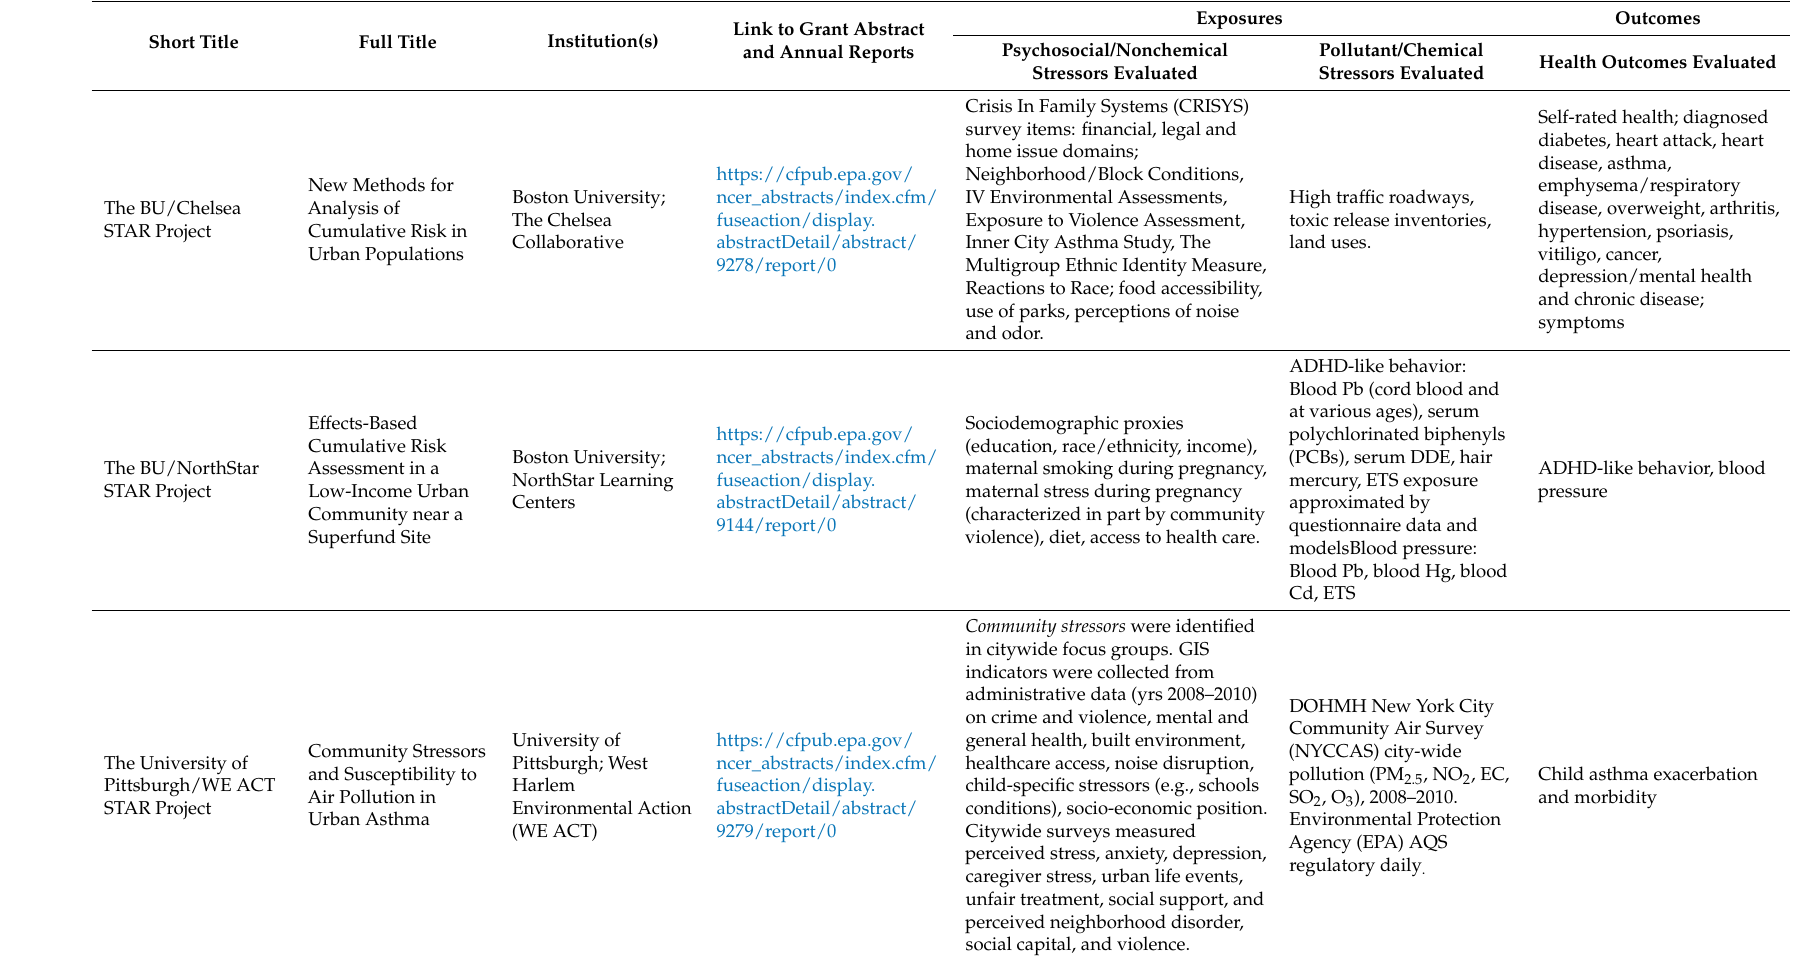
Table 1. Overview of the Science to Achieve Results (STAR) understanding the role of nonchemical stressors and developing analytic methods for cumulative risk assessments